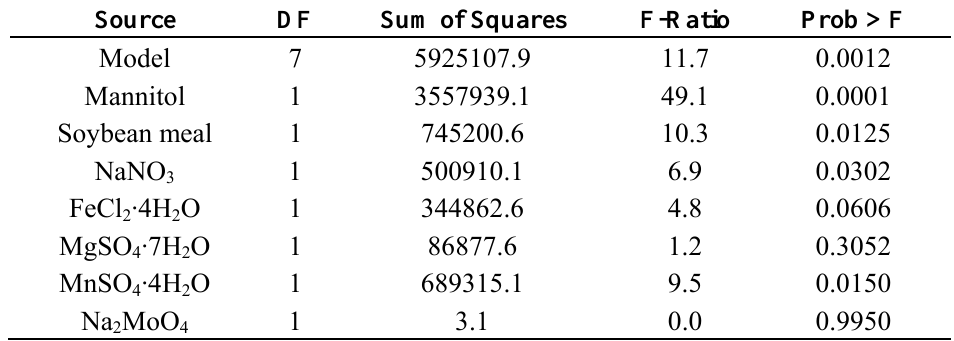
Table 3. Identifying significant variables for fengycin production using fractional factorial design a